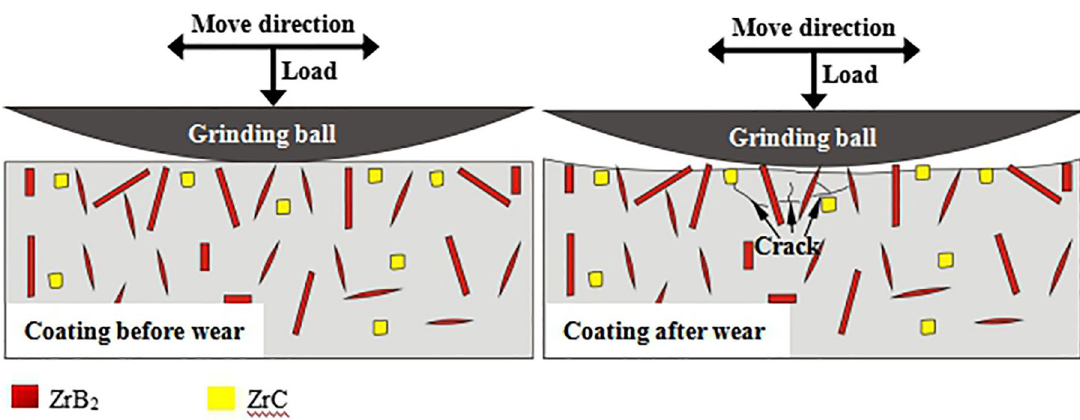
Figure 11. Schematic diagram of abrasive wear mechanism of the